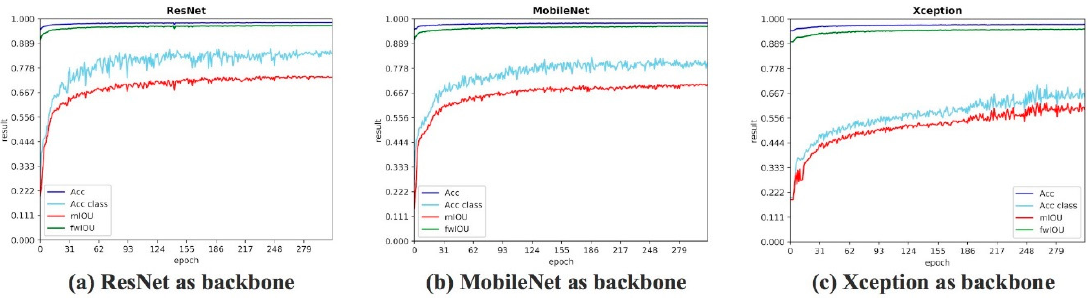
Figure 8. Result of segmentation using different backbone.